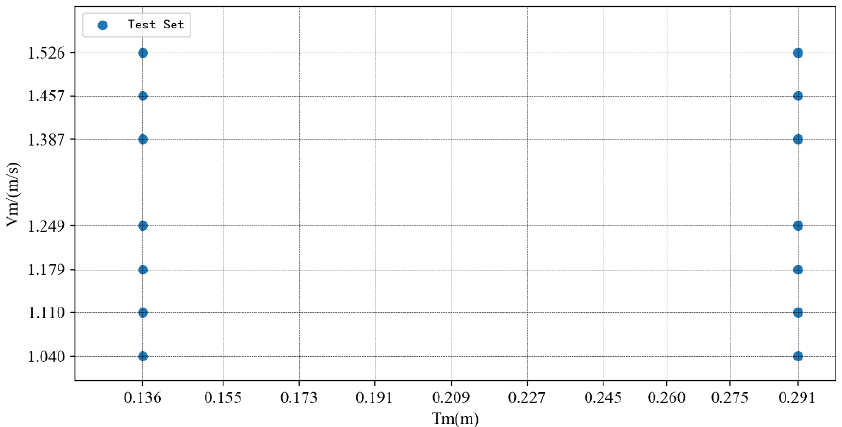
Figure 6. The distribution of test set samples for extrapolation prediction.